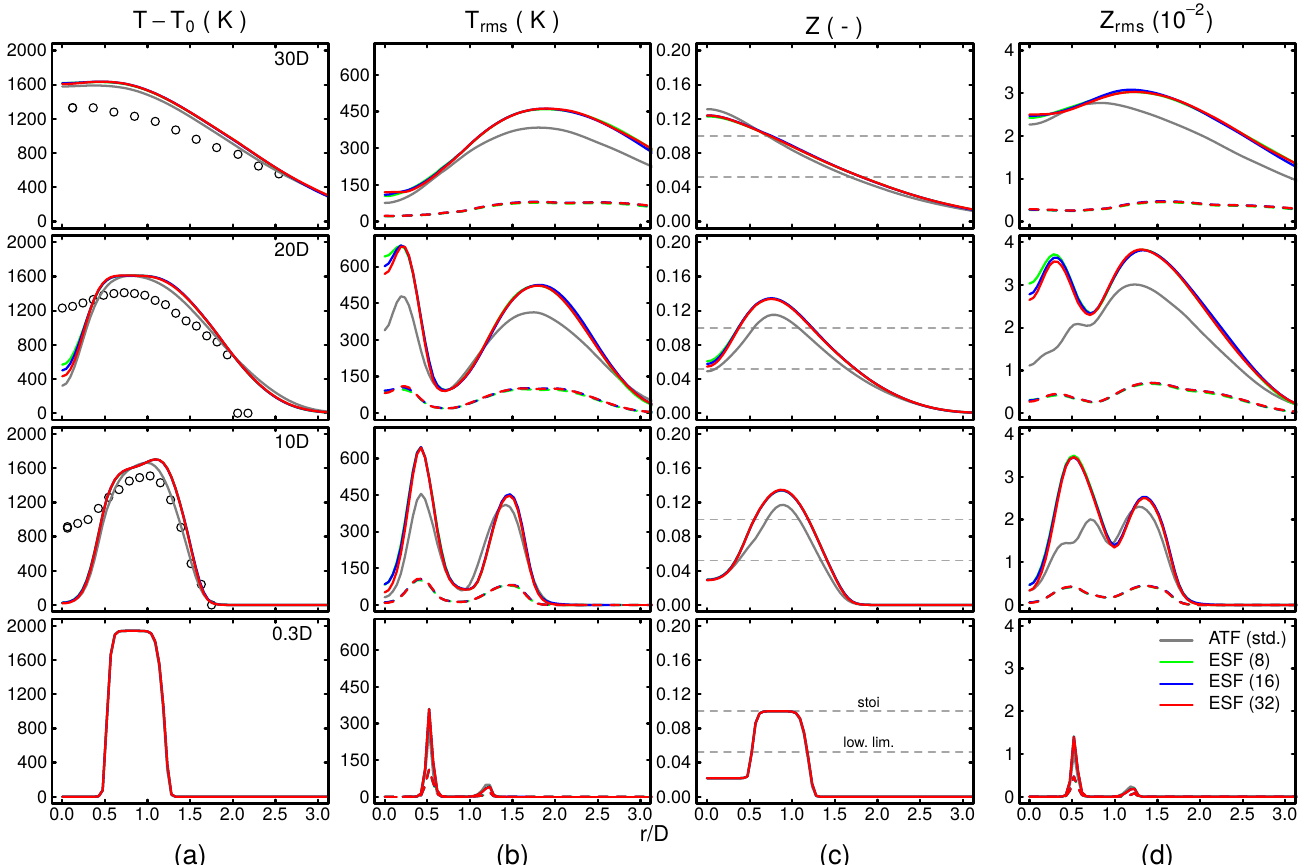
Figure 4. Mean excess temperature ( a ), temperature rms ( b ) along with mixture fraction mean ( c ) and rms ( d ) at various axial distances from the burner exit compared with available experimental data. The dashed lines correspond to the unresolved contributions obtained from the LES-ESF simulations. The horizontal grey dotted line shown in ( c ) correspond to lower flammability and